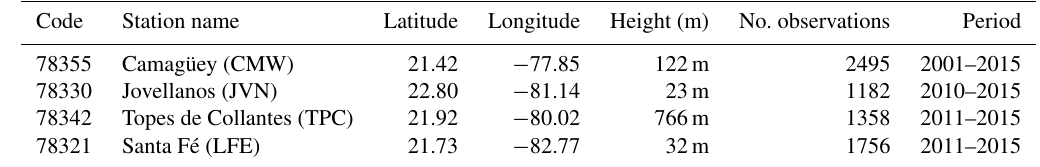
Table 2. Information about Cuban actinometric stations operating under the Solar Radiation Diagnostic Service (SRDS). Available number of BAOD observations are included in column 6 and the period is covered in the last